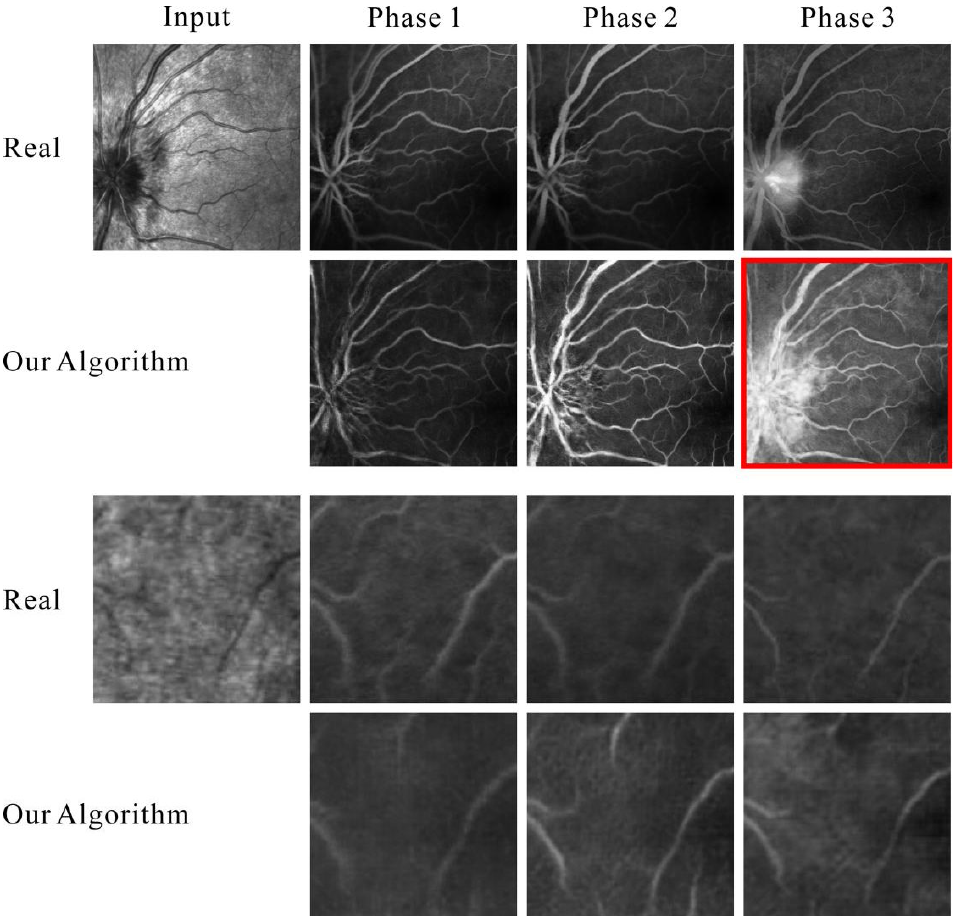
Figure 7. Two representative examples of our image translation are presented. The first example is from a wide field of view and the second example is from a narrow field of view. The images with red square boxes show that our algorithm can successfully translate ONH leakages.